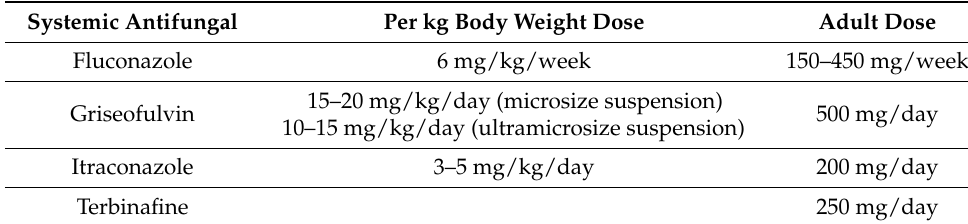
Table 3. Paediatric and adult dosing of systemic antifungals.